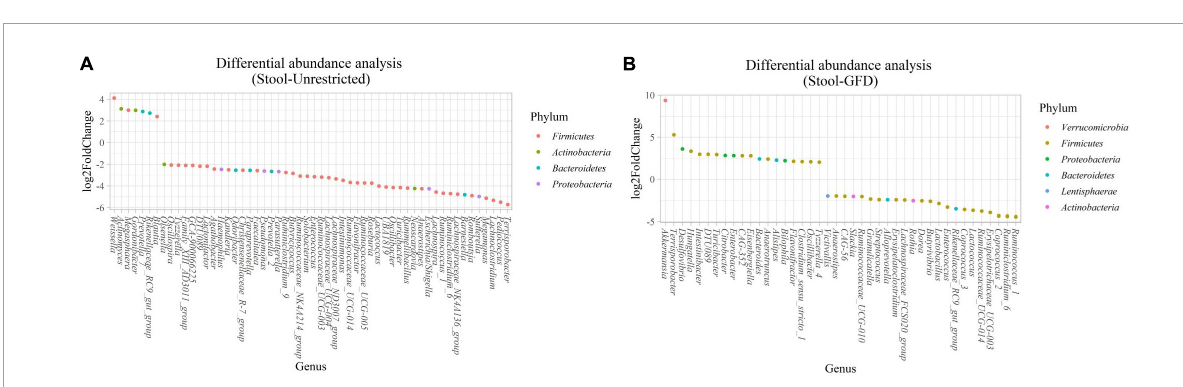
FIGURE6 Differential abundance analysis performed on samples from the stool of patients with CeD following an unrestricted diet (A) and patients with CeD under a GFD (B) compared with healthy